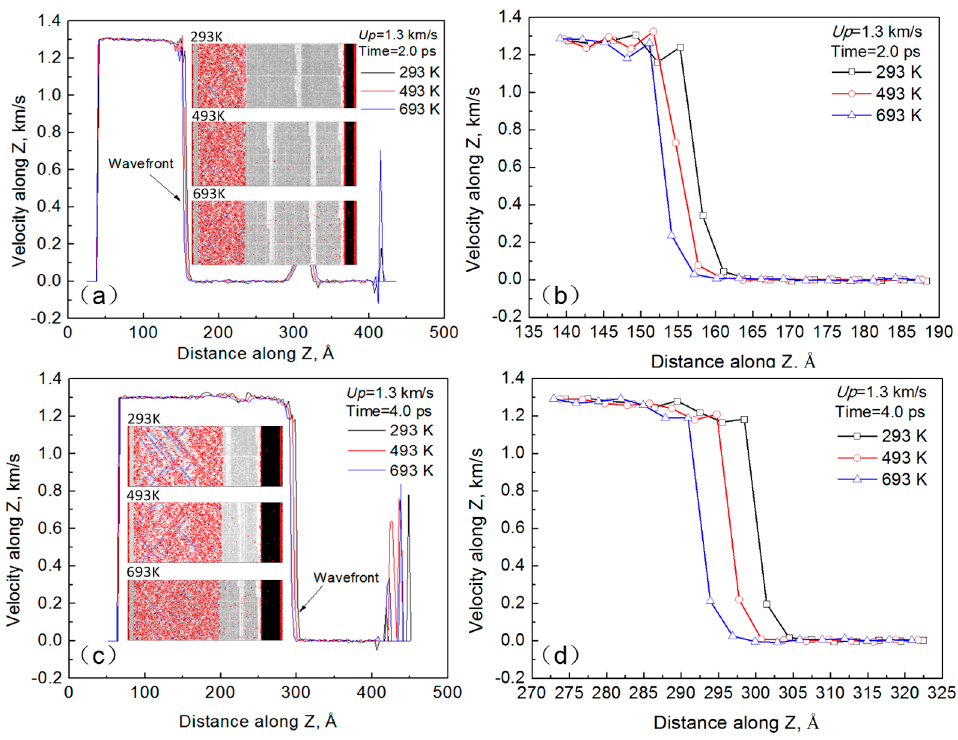
Figure 4. Atomic velocities in shock direction and wavefronts under different temperatures. Loading for ( a ) 2 ps and ( c ) 4 ps. ( b , d ) are wavefronts of ( a , c ).